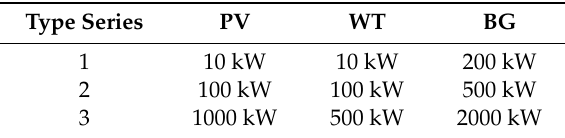
Table 1. Rated power of the renewable energy sources (RES).